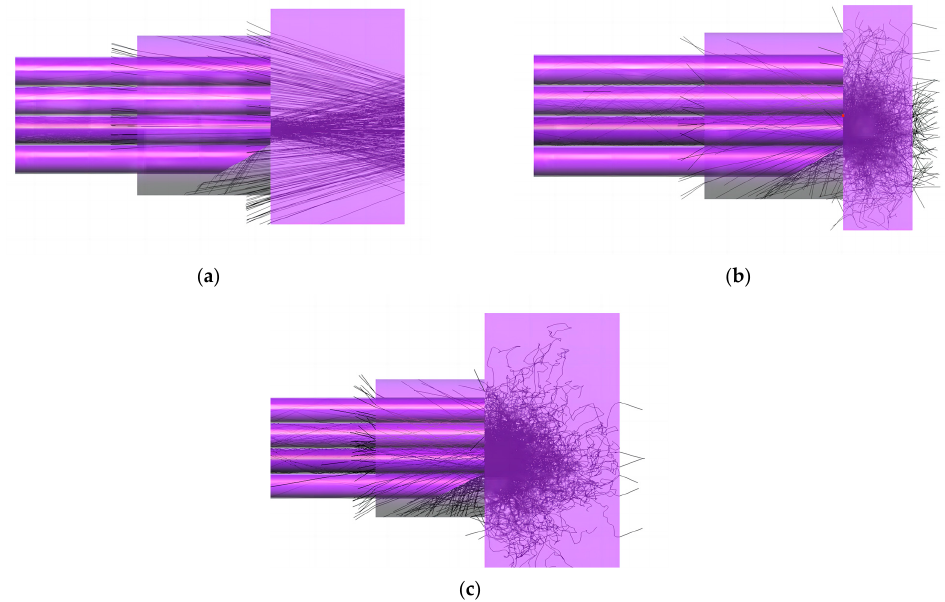
Figure 3. Propagation of light in different ice types: ( a ) glazed ice with 5 mm thickness; ( b ) rime ice with 2 mm thickness; ( c ) rime ice with 5 mm thickness.